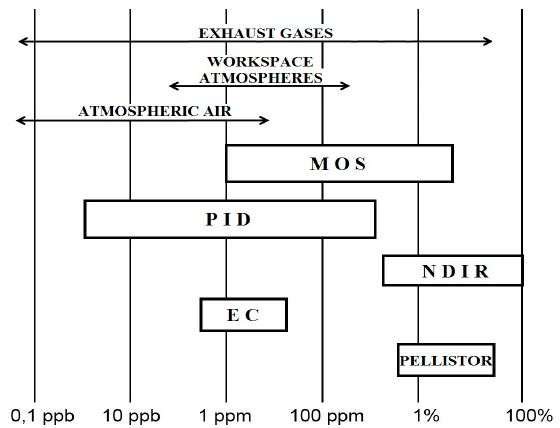
Figure 1. The concentration range of VOCs present in ambient air, indoor air at workplace and in